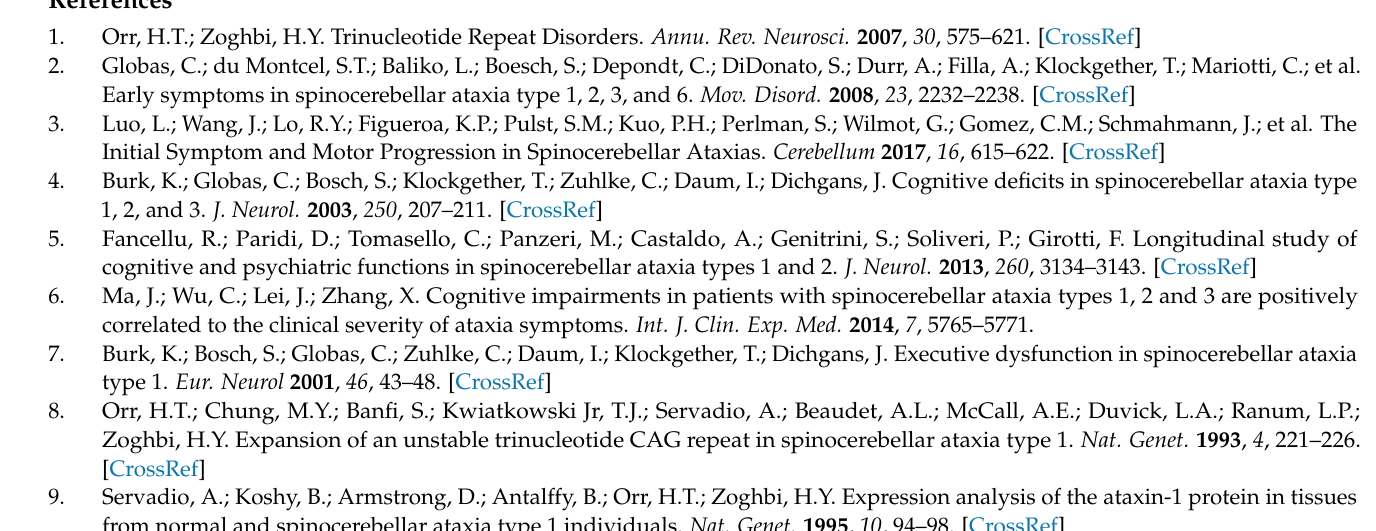
to Figure 4, Heatmap of top 20 DEGs across SCA1 KI mouse cortex and cerebellum at 12 weeks; Figure S4: Supplement to Figure 4, Top Molecular Function (MF) GO terms for downregulated DEGs of the SCA1 mouse cortex and cerebellum; Figure S5: Supplement to Figure 4, Top Biological Process GO terms for downregulated DEGs of the SCA1 KI mouse cortex and cerebellum; Figure S6: Supplement to Figure 4, Top Biological Process GO terms for upregulated DEGs of the SCA1 KI mouse cortex and cerebellum; Table S1: Supplement to Figures 3 and 4, DEG list of the SCA1 KI mouse cortex and cerebellum at 12 weeks; Table S2: Supplement to Figure 3, Gene Ontology terms of downregulated DEGs in the SCA1 KI mouse cortex at 12 weeks, generated using g:Profiler; Table S3: Supplement to Figure 3, Gene Ontology terms of upregulated DEGs in the SCA1 KI mouse cortex at 12 weeks, generated using g:Profiler; Table S4: Supplement to Figure 4, Shared and unique Gene Ontology (GO) terms of the SCA1 KI mouse cortex and cerebellum at 12 weeks for downregulated DEGs in each region, generated using g:Profiler; Table S5: Supplement to Figure 4, Shared and unique Gene Ontology (GO) terms of the SCA1 KI mouse cortex and cerebellum at 12 weeks for upregulated DEGs in each region, generated using